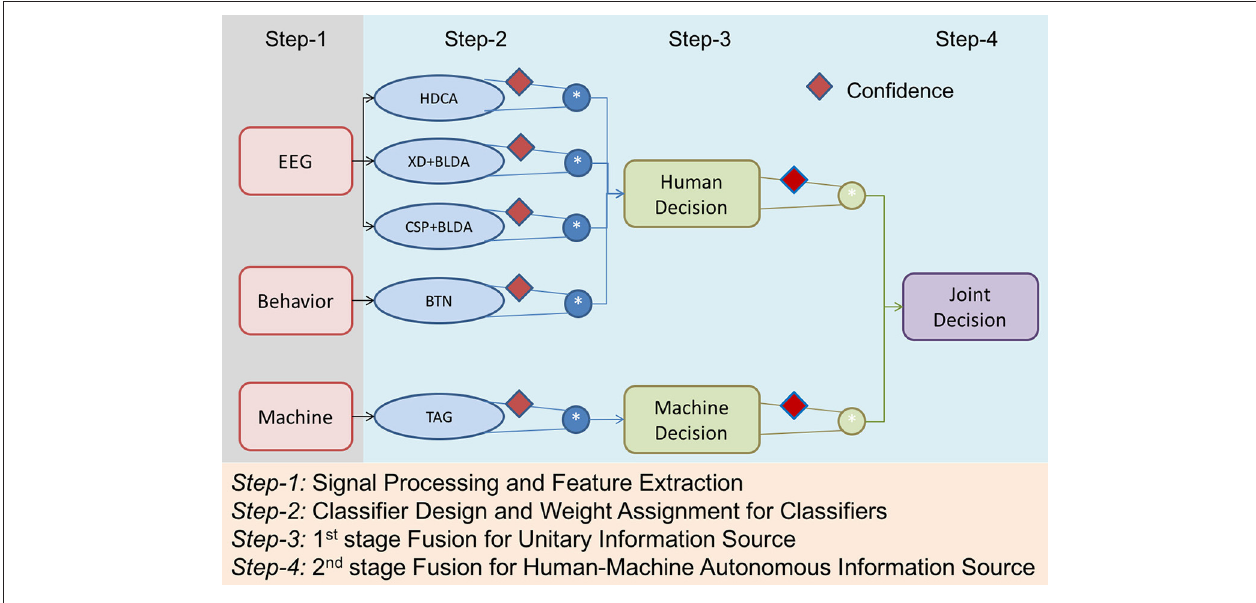
FIGURE 2 | Flowchart of the Human-Machine Autonomous System.